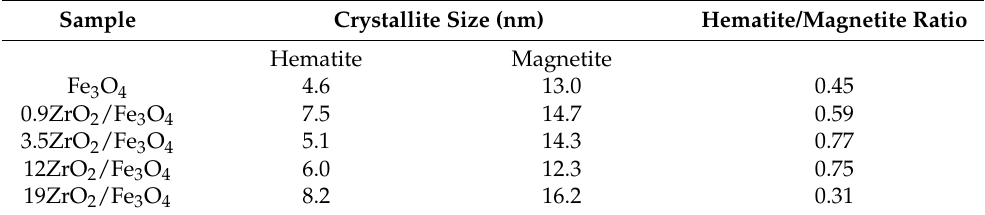
Table 2. Results of XRD